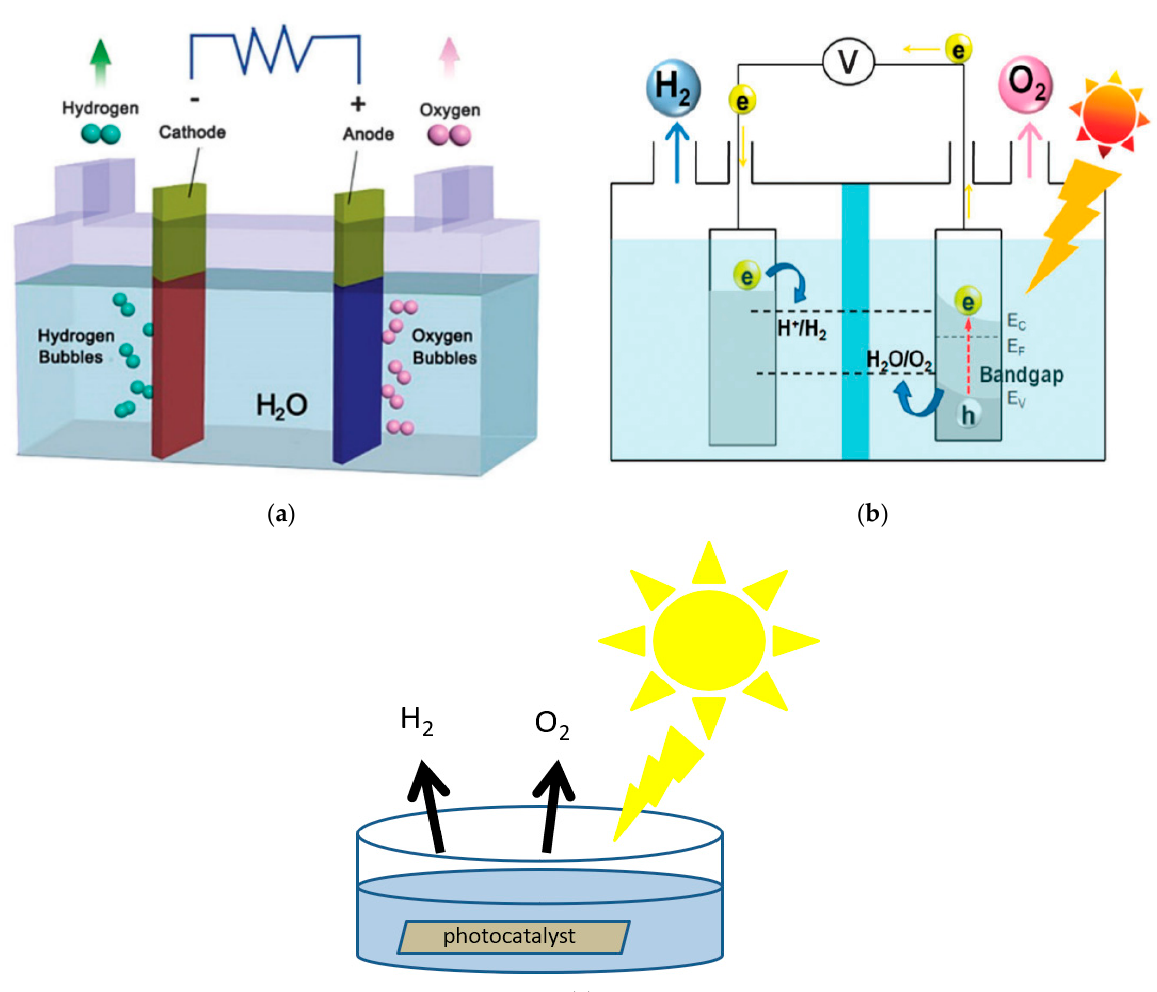
Figure 1. Processes of ( a ) water electrolysis [1] (reprinted with permission from ref. [1]), ( b ) photo- electrochemical water splitting [8] (reprinted with permission from ref. [8]), and ( c ) photocatalytic water splitting.